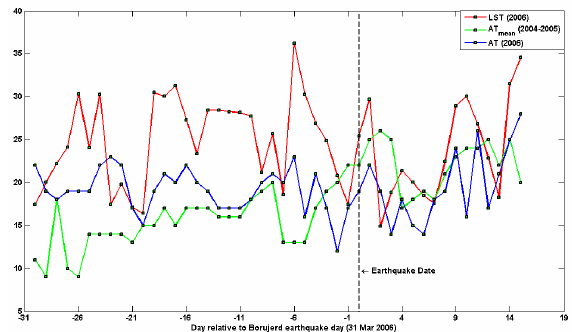
Fig. 3. Results of LST and AT data analysis for the Borujerd earth- quake (31 March 2006) from 1 March to 15 April 2006. The mean Figure 3. Results of LST and AT data analysis for the Borujerd earthquake (31 March 2006) from 3 of AT during the period of 01 March to 15 April from 2004 to 2005 01 March to 15 April 2006. The mean of AT during the period of 01 March to 15 April from 4 is represented as a green curve. 2004 to 2005 is represented as green curve. 5 the period of 20 November 2003 to 3 January 2004. The mean of the AT data from 1998 to 2002 during the period of 20 November to 3 January is represented by a green curve. The X-axis represents the days relative to the earthquake day. The vertical dotted line shows the earthquake date. Figure 4a shows variations of the corrected LST, close to the Bam earthquake epicenter during the period of 20 November 2003 to 03 January 2004. Median, and higher and lower bounds are seen as blue and green horizontal lines,